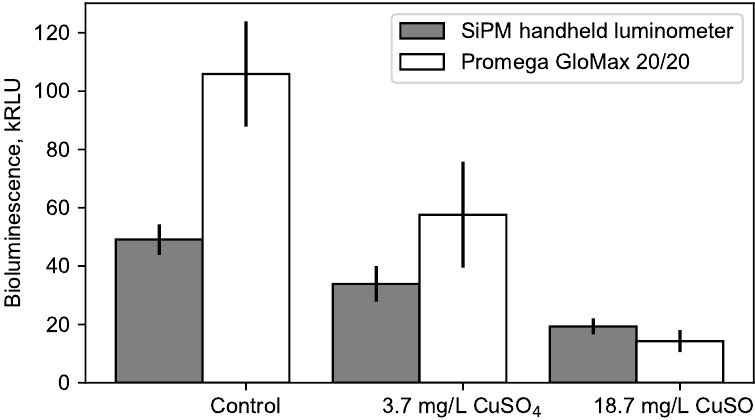
Figure 4. Sensitivity comparison of the biosensor and Promega GloMax 20/20 luminometer by measuring copper(II) sulphate at different